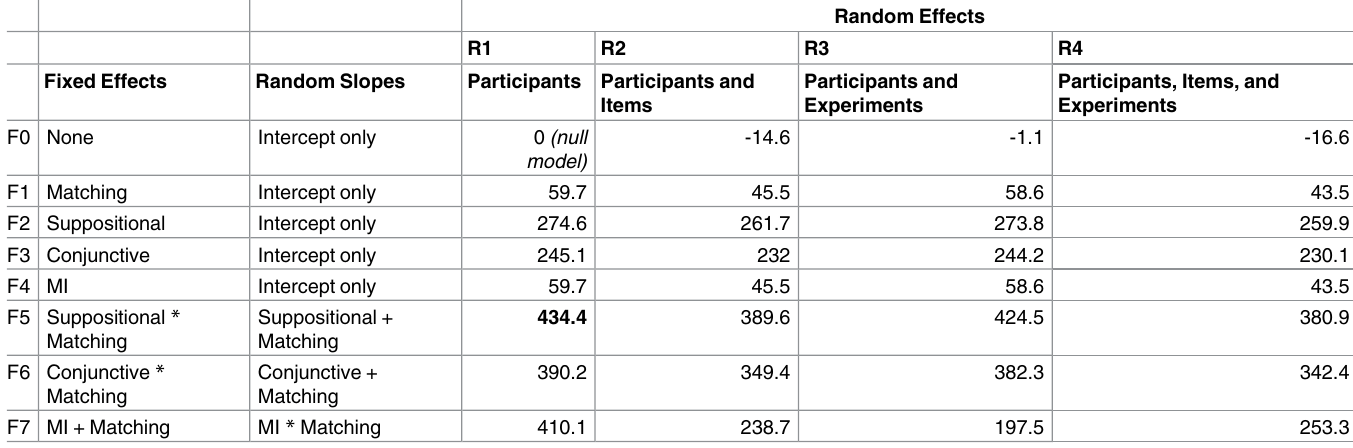
Table 6. Summaryof the Results of the BayesianMixed Model Meta-analysis